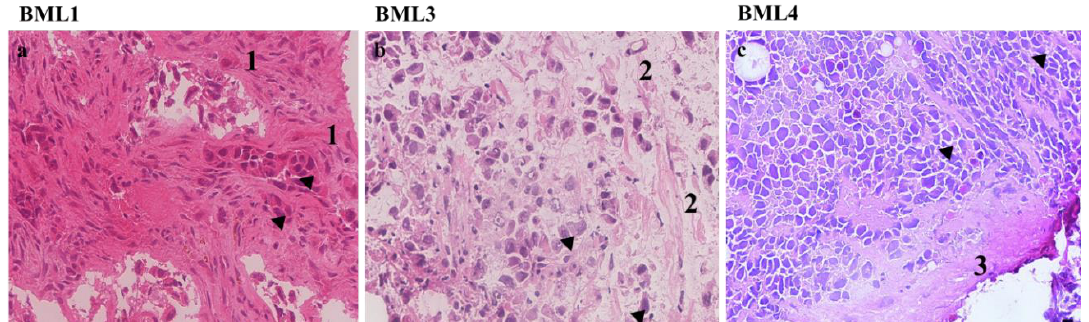
Figure 1. Histology hematoxylin – eosin (H&E) staining images of the three bone metastasis biopsies secondary to lung cancer (BML1, BML3 and BML4). ( a ) BML1, Non-small lung cancer cells, 1 designates abundant desmoplastic stroma. ( b ) BML3, non-small lung cancer cells, 2 edematous stroma. ( c ) BML4, small lung cancer cells, 3 Scant fibrous stroma. Black arrow heads indicate epithelial tumor cells with hyperchromatic pleomorphic nuclei and high nuclei / cytoplasm ratio. Scale bar 10 µ